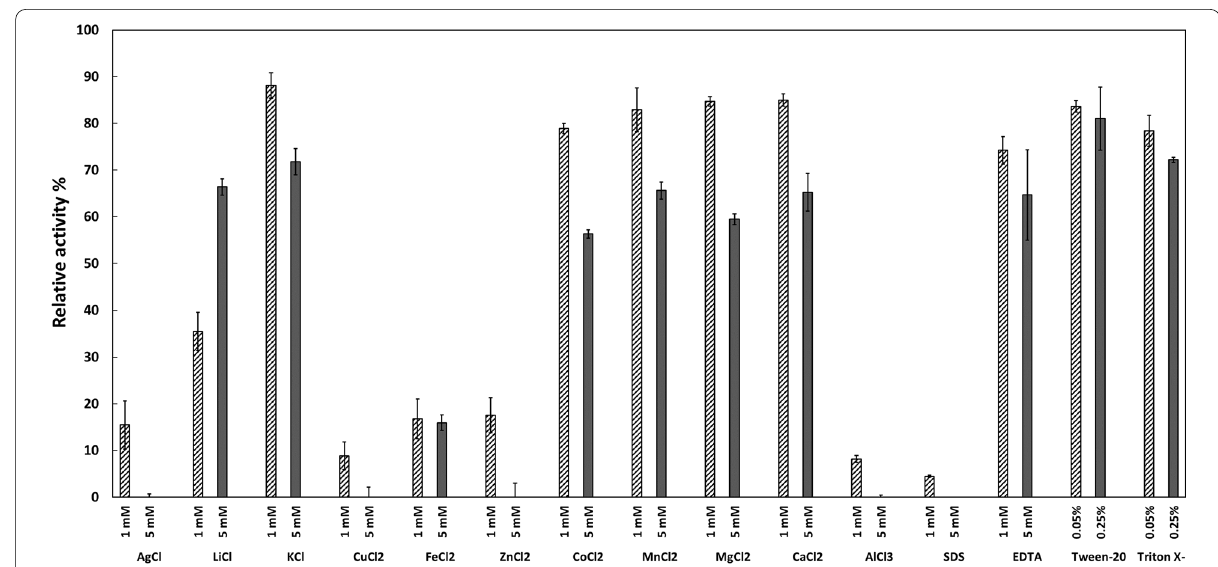
Fig. 6 Effect of ions, surfactants and EDTA on NAGase activity. TvmNAG2 was incubated with additional metal ions, surfactants or EDTA at the indicated concentration, followed by activity assay. The activity of TvmNAG2 without any effector was as 100% activity. The experiments were repeated triple with standard deviation